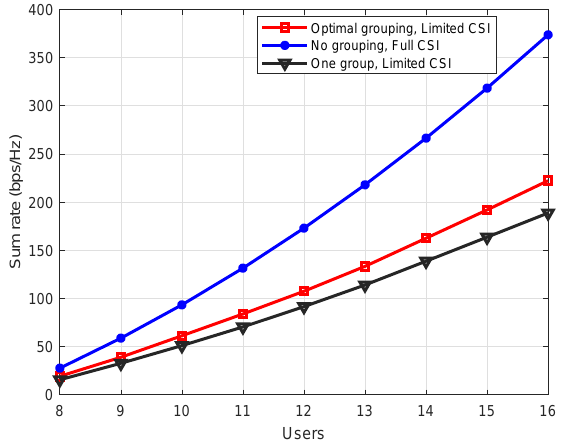
Figure 10. Sum-rate Vs number of users with different number of groups and CSI, SNR = 10